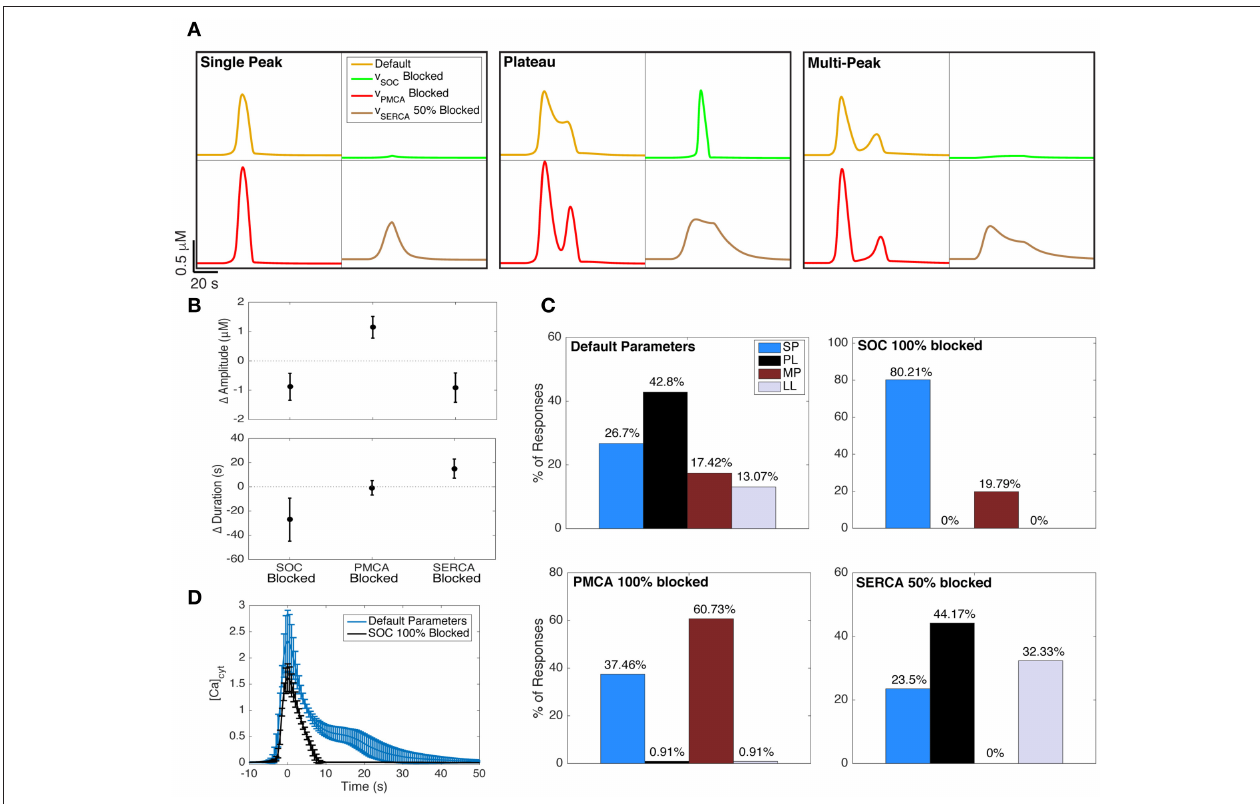
FIGURE 6 | Effect of blocking Ca 2 + channels and pumps on Ca 2 + responses. (A) The effects of blocking SOC channels (green traces), PMCA pumps (red traces), and SERCA pumps (brown traces) on example SP, PL, and MP responses generated with the default model parameters (yellow traces). The underlying IP 3 dynamics for each panel are, from left to right (in order, A , d rise , r rise , d dec ): 0.2, 21, 0.002, 97 (SP), 0.375, 36, 0.002, 120 (PL), 0.2, 41, 0.15, 179 (MP). The IP 3 input was applied 20s after the start of the simulation. (B) The change in Ca 2 + response amplitude and duration after blocking the three channels and pumps. For all 600 IP 3 inputs, the mean change in response kinetics from the default Ca 2 + response is shown, with its standard deviation. (C) The effects of blocking the channels and pumps on Ca 2 + response type distributions. The upper left distribution (corresponding to default parameters) is repeated from the left panel of Figure 5A . (D) The average PL response with default model parameters (IP 3 d rise < 22s, as in the right panel of Figure 5A ) shown in blue. Using the same underlying IP 3 dynamics as the input, we also generated the average Ca 2 + response when SOC channels were fully blocked (black trace). As observed, the plateau phase of Ca 2 + responses is eliminated when SOC channels are blocked in our model. To generate these average traces, the trace peaks were first aligned, ignoring latency. Error bars indicate standard